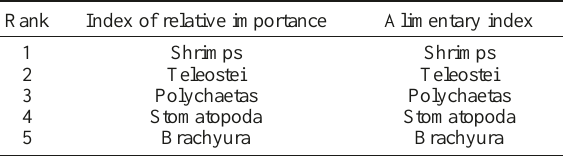
Table 2. – Ranking of importance of each category of prey item identified in the stomach content of P. maculatus according to each importance index.